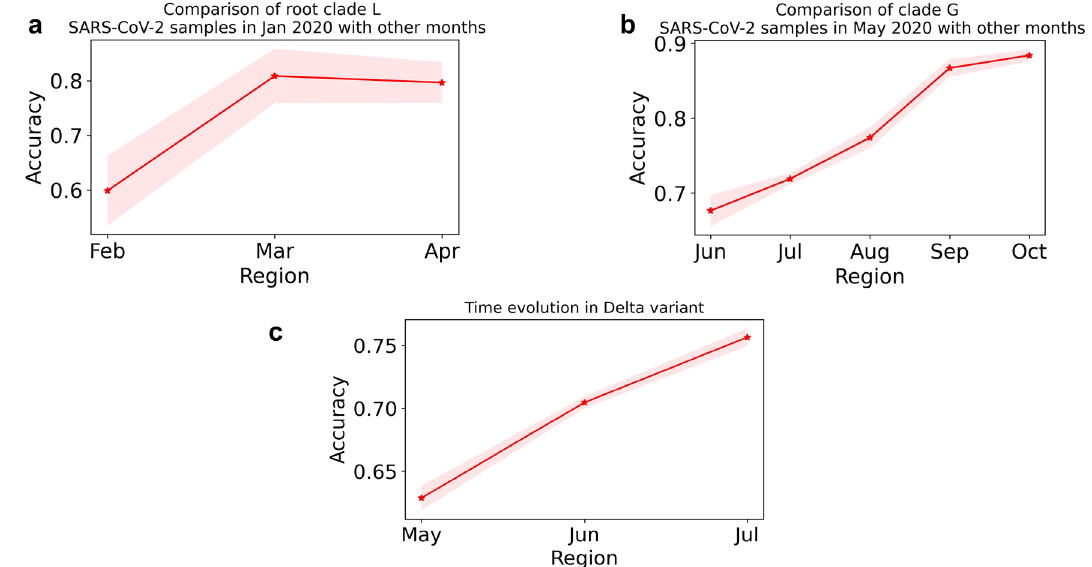
Figure 4. Continuous Evolution. A variant/strain is defined by deterministic stable mutations, however, evolution is characterized by the randomness of the transient mutations. In these plots, we quantify this randomness for different SARS-CoV-2 clades by comparing SARS-CoV-2 sequences within the same clade/ variant in different months. ( a ) represents validation accuracy of a logistic regression classifier built using state machine representations of SARS-CoV-2 sequences (with k = 4 , b = 1 , β = 0.5 ) in January 2020 with the months of February, March and April 2020 within GISAID clade L. ( b ) represents validation accuracy of a logistic regression classifier built using state machine representations of SARS-CoV-2 sequences (with k = 4 , b = 1 , β = 0.5 ) in May 2020 with the months of June, July, August, September and October 2020 within GISAID clade G. ( c ) represents validation accuracy of a logistic regression classifier built using state machine representations of SARS-CoV-2 sequences (with k = 4 , b = 1 , β = 0.5 ) in Apr 2021 with the months of